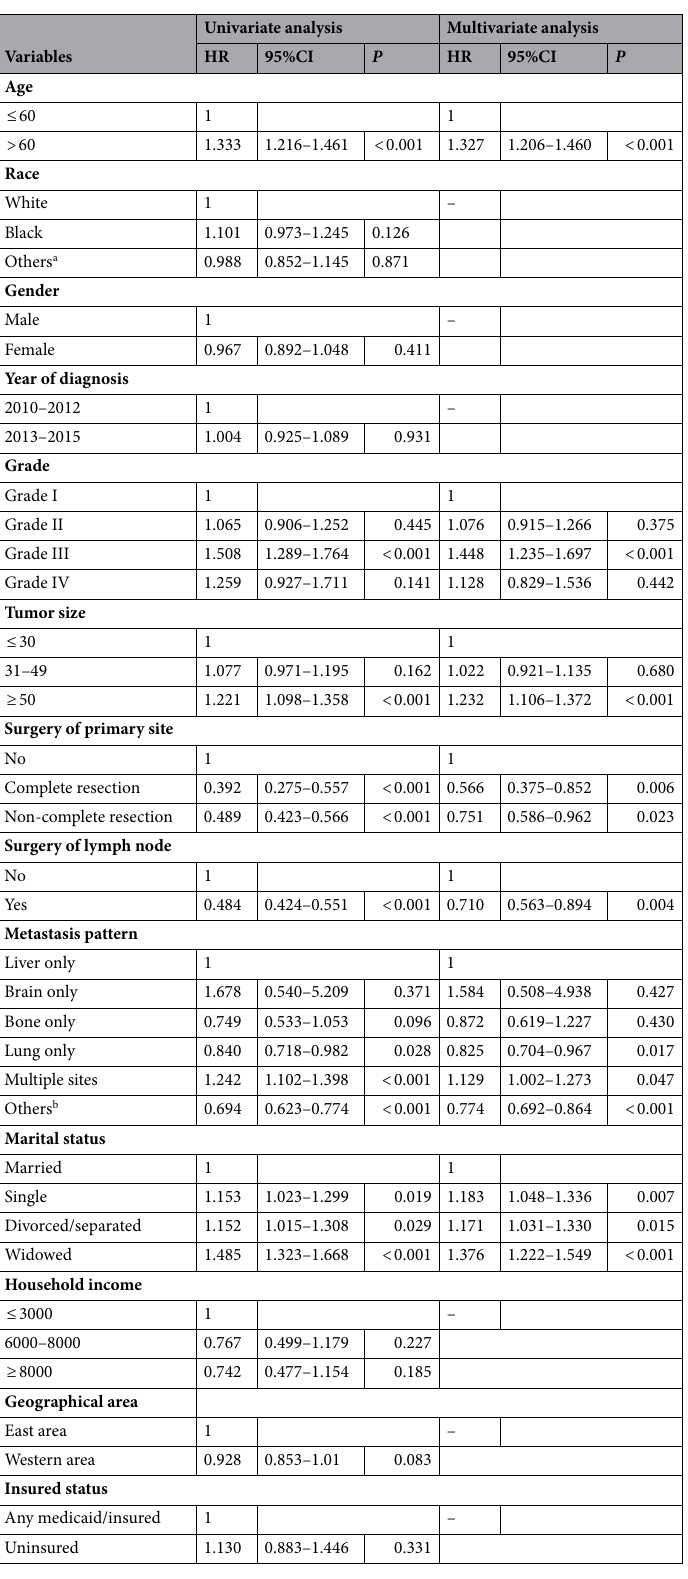
Table 2. The Cox proportional hazards regression model analysis of overall survival (OS) in the primary cohort. a American Indian/AK Native, Asian/Pacific Islander; b Para-aortic lymph nodes, duodenum lymph nodes, peripancreatic lymph nodes,